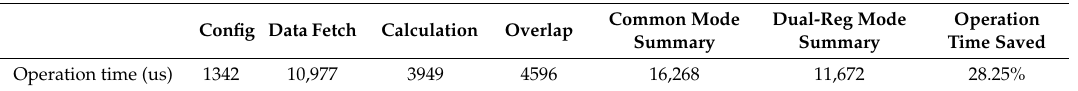
Table 4. Operation e ffi ciency improvement of the dual register group structure in the WBC classification network.